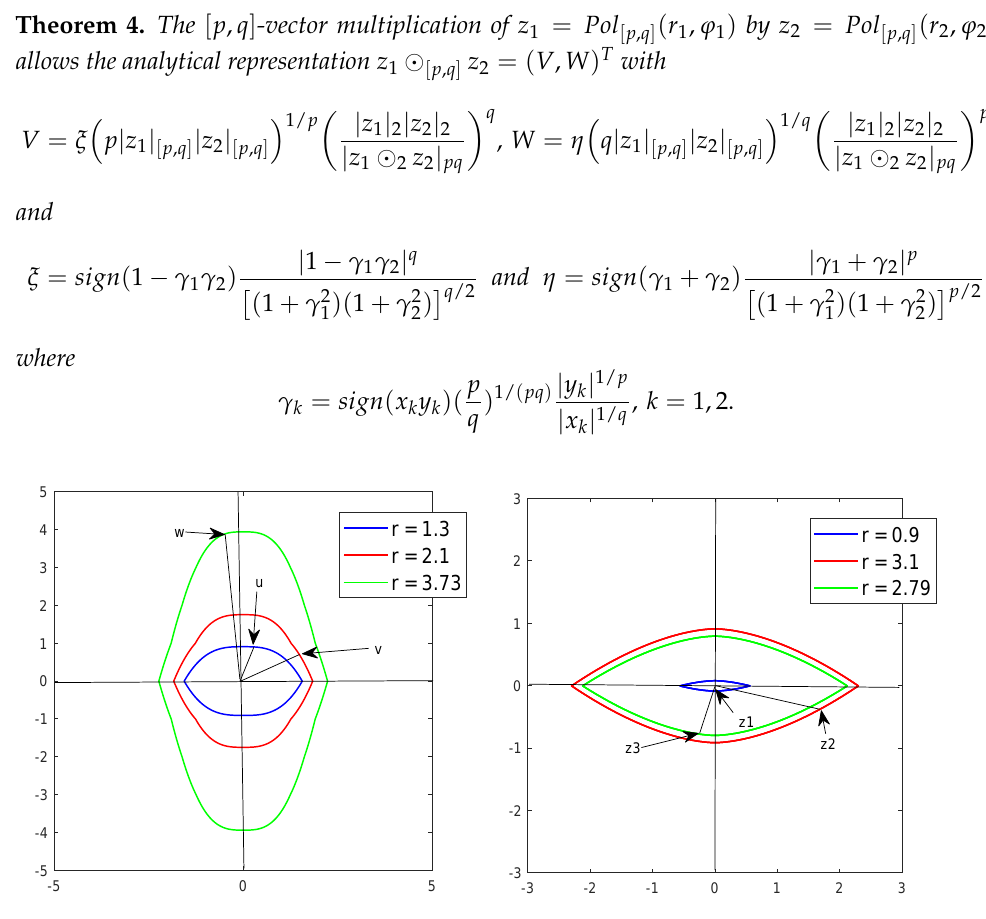
Figure 11. Vector [ p , q ] -products w = u (cid:12) [ 3, 0.7 ] v and z 3 = z 1 (cid:12) [ 1.7, 0.3 ] z